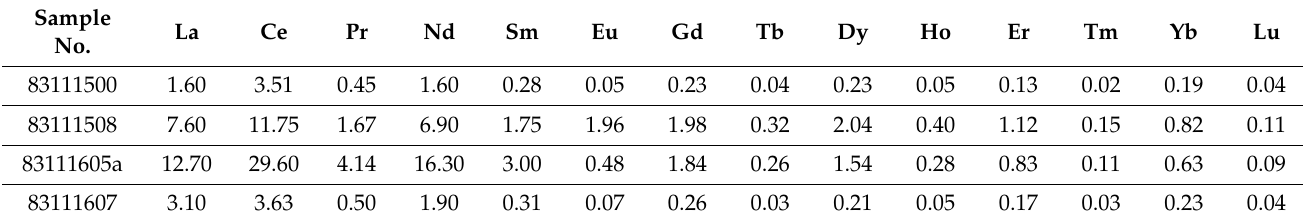
Table 2. REE concentrations in the Kamioka ores and a crystalline limestone in ppm.